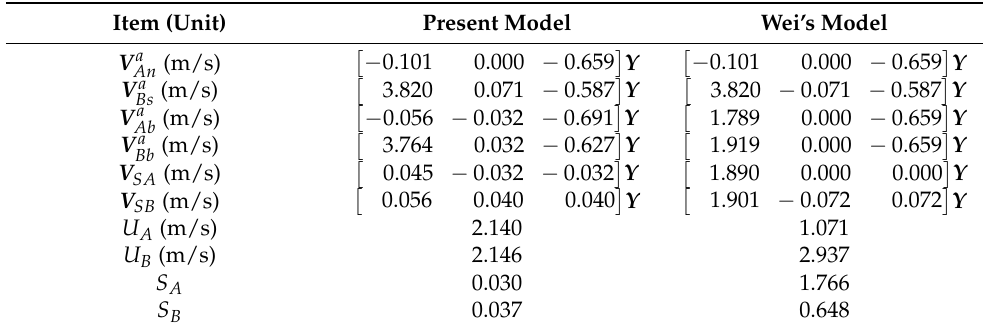
Table 2. Results using ball screw parameters. Item (Unit) Present Model Wei’s